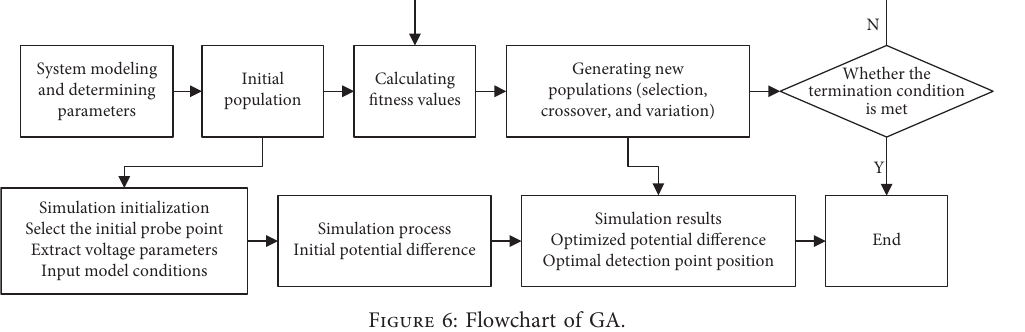
Figure 6: Flowchart of GA.